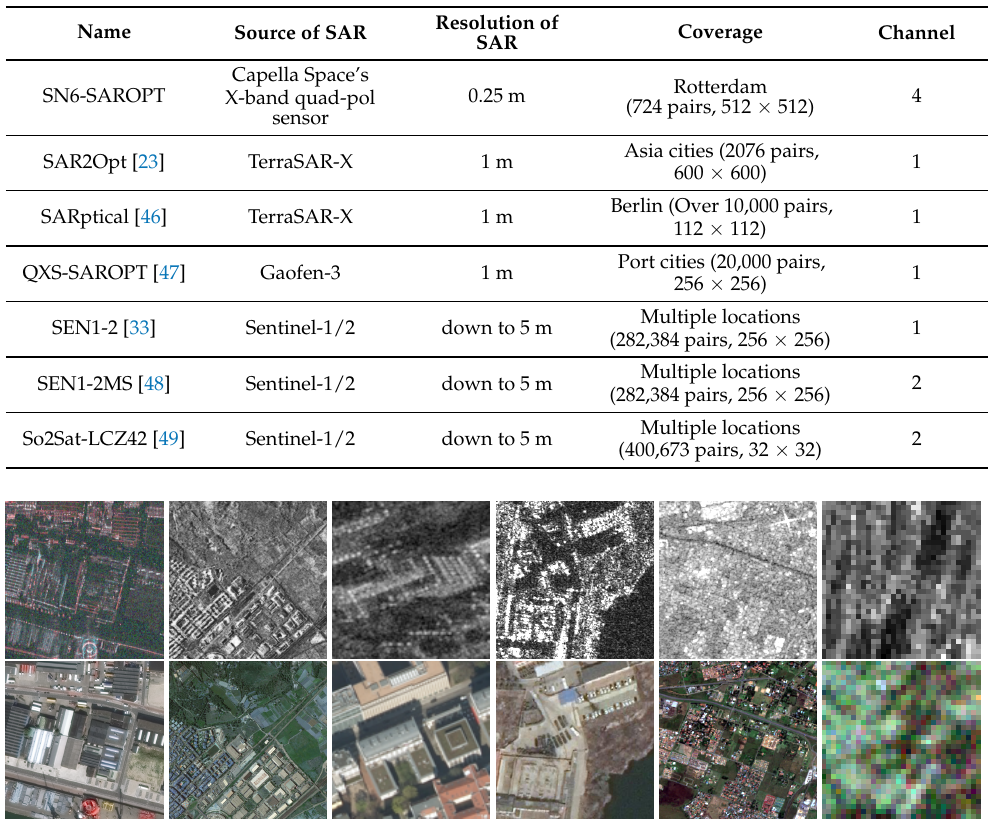
Figure 6. Sample patches of paired EO-SAR datasets. From ( left ) to ( right ): SN6-SAROPT, SAR2Opt, SARptical, QXS-SAROPT, SEN1-2/SEN1-2MS, So2Sat-LCZ42. The ( top ) row depicts the SAR images and the ( bottom ) row depicts the corresponding EO images. The shown image patches are resized to the same scale for visualization